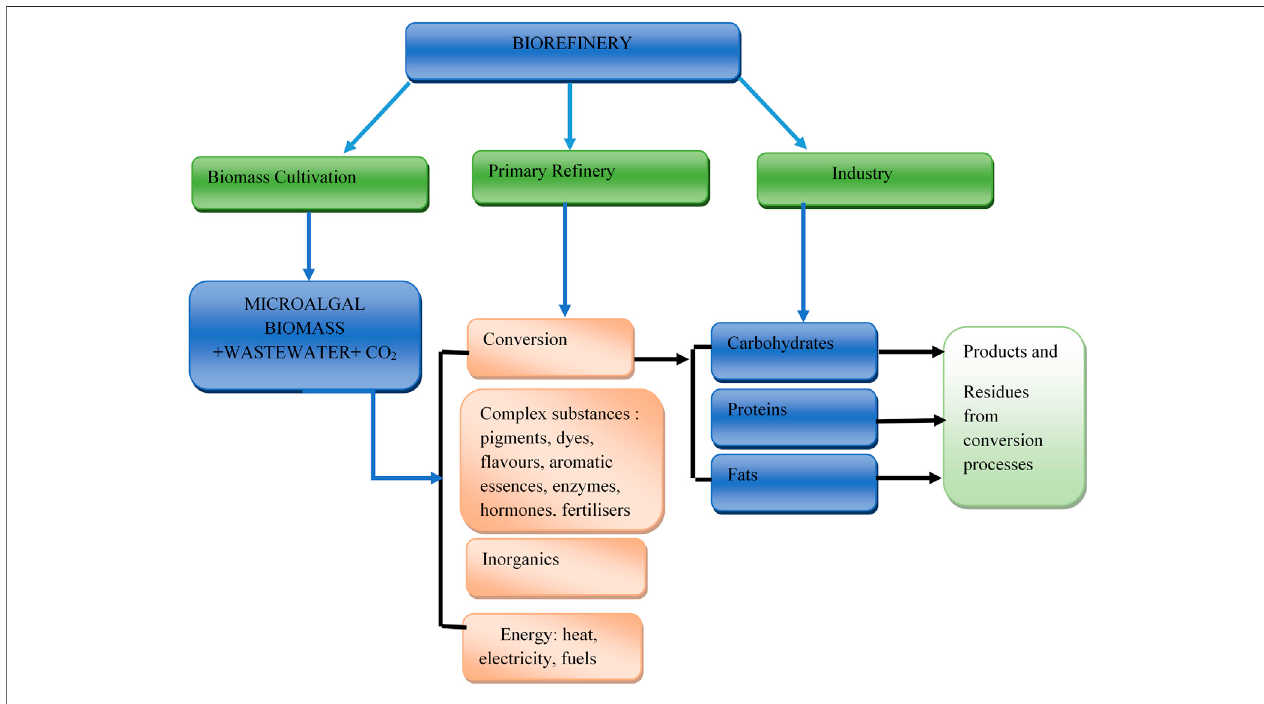
FIGURE 3 | Biore fi nery concept model adapted from (U.S. DOE, 2010).